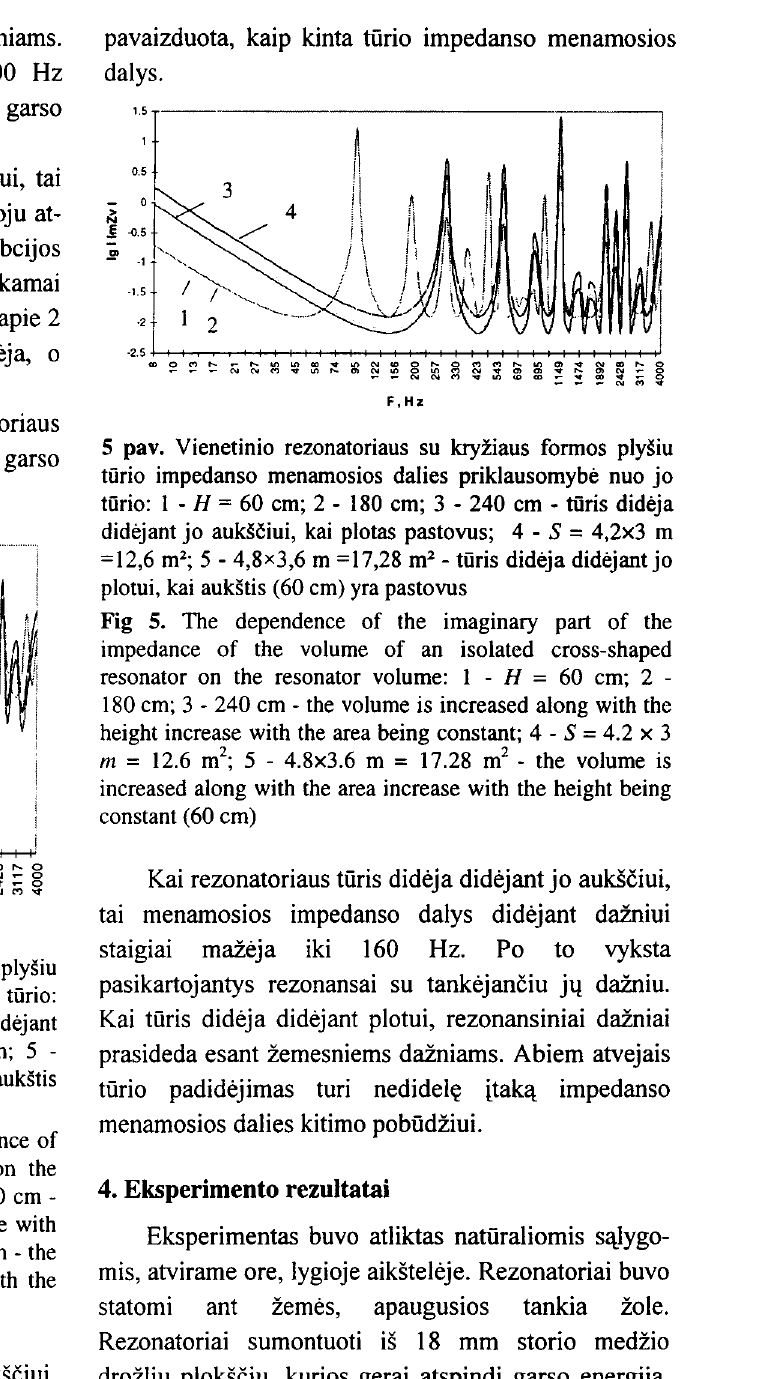
kartojimo damis vis tankeja. Kai turis dideja didejant rezonatoriaus plotui, tai realiosios impedanso dalys taip pat tolygiai maZeja augant damiui. Taciau siuo atveju didejant turiui rezonansQ daZnis maZeja, o jQ amplitudes darosi vis didesnes.